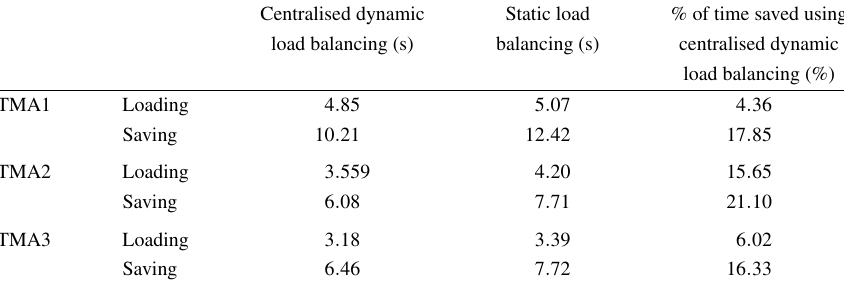
Percent of processing time saved using centralised dynamic load balancing over static load balancing Centralised dynamic Static load % of time saved using load balancing (s) balancing (s) centralised